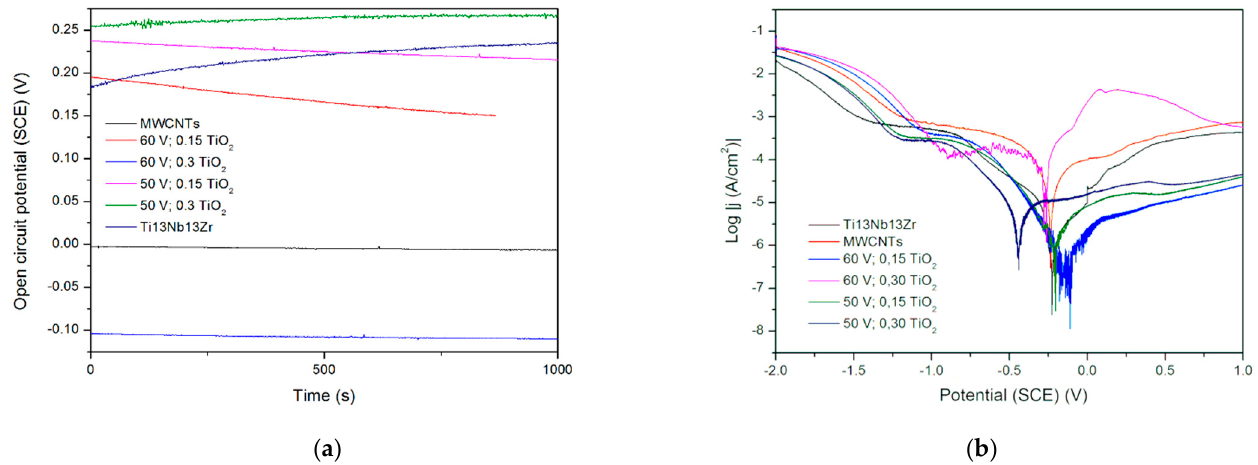
Figure 8. ( a ) Open circuit potential for different modifications, ( b ) potentiodynamic corrosion curves obtained for Ti13Nb13Zr substrate after its surface modifications. Ti13Nb13Zr—ground, MWCNTs—ground and coated in MWCNTs solution, other curves—ground, coated in MWCNTs solution and coated again in TiO 2 solution (layer-by-layer), at different contents and voltages.